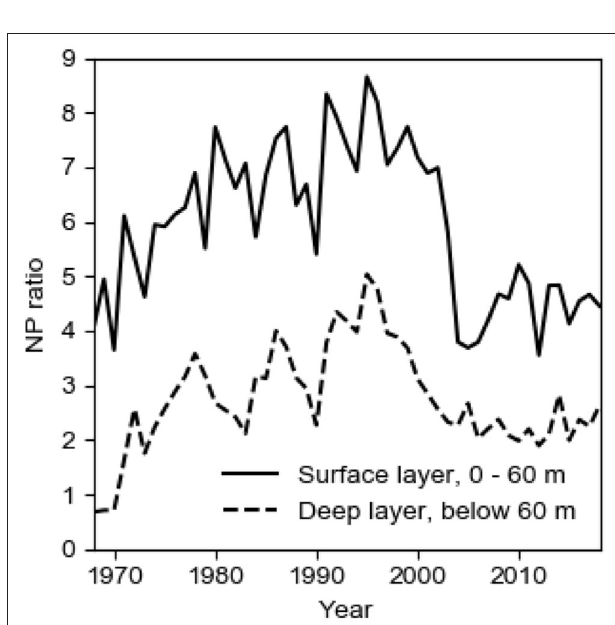
FIGURE 4 | The long-term (1968–2018) evolution of the volume-weighted NP ratio, here (NO3 + NH4)/PO4 in winter in the 60m thick surface layer and in the deepwater of the Baltic proper. Data from SMHI